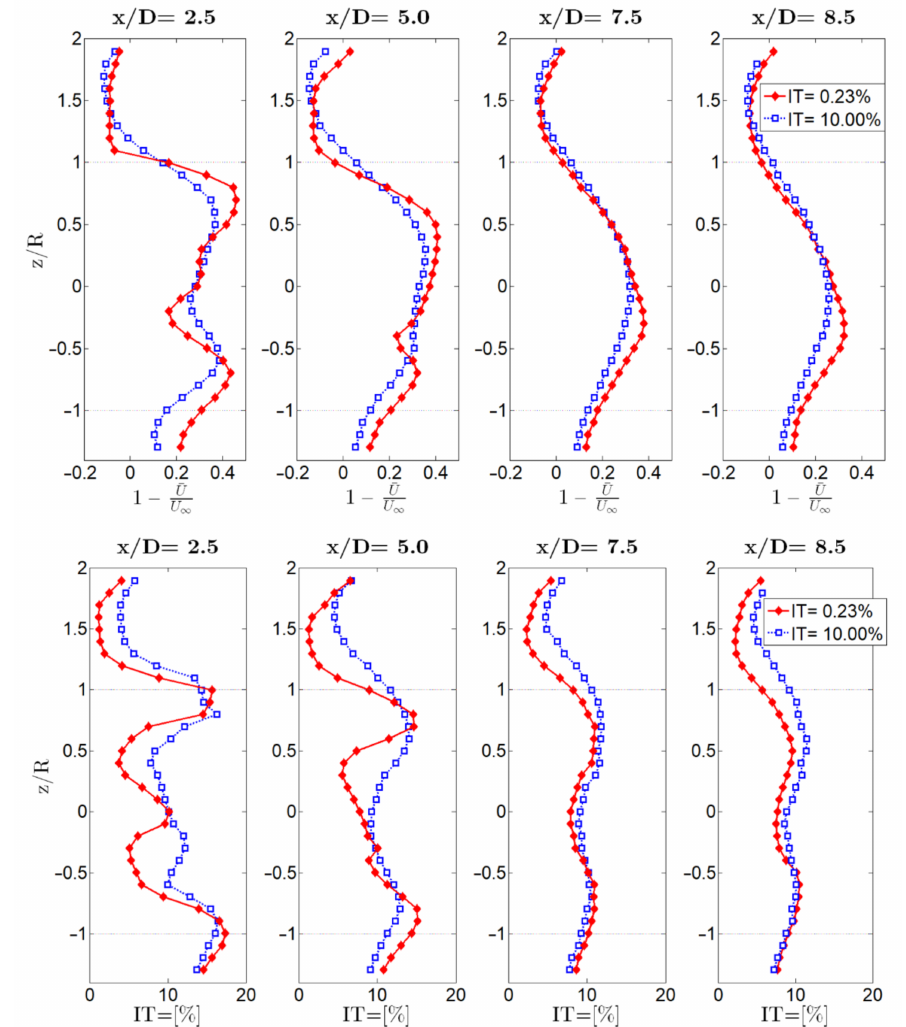
Figure 8. Velocity deficit ( top ) and turbulence intensity ( bottom ) in the vertical plane between two turbines for x/D = 2.5, 5.0 and 7.5 and downstream T1 for x/D = 8.5. λ _T1 = 6.0 and λ _T2 = 5.0. High turbulence intensity inflow marked blue, low marked red.